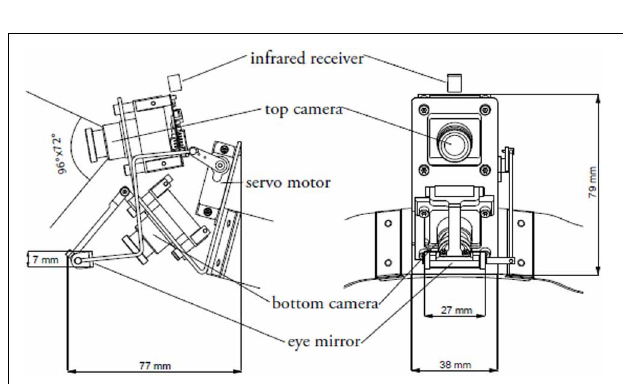
FIGURE 1 | The WearCam consists of a wearable elastic strap (right) mounted with a pair of cameras. The top camera gives a view of the “interaction” zone while the bottom camera gives a view of the “lower zone.” A mirror mounted on the bottom camera reflects the child’s eyes for tracking the user’s gaze (right).